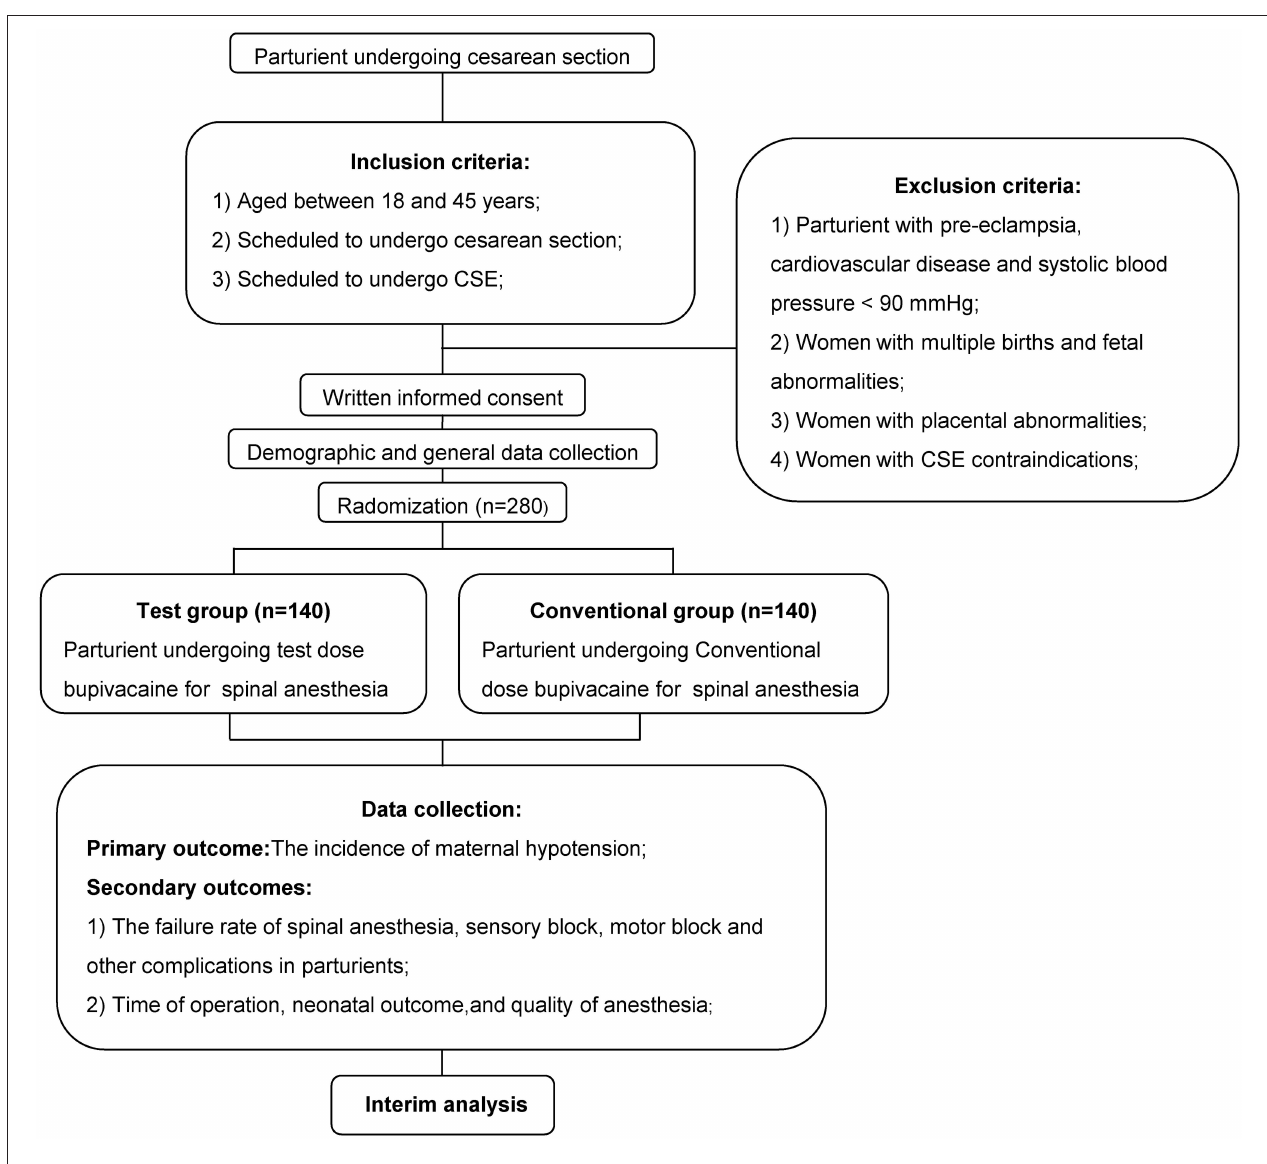
FIGURE 1 | Study flow chart. CSE, combined spinal–epidural.